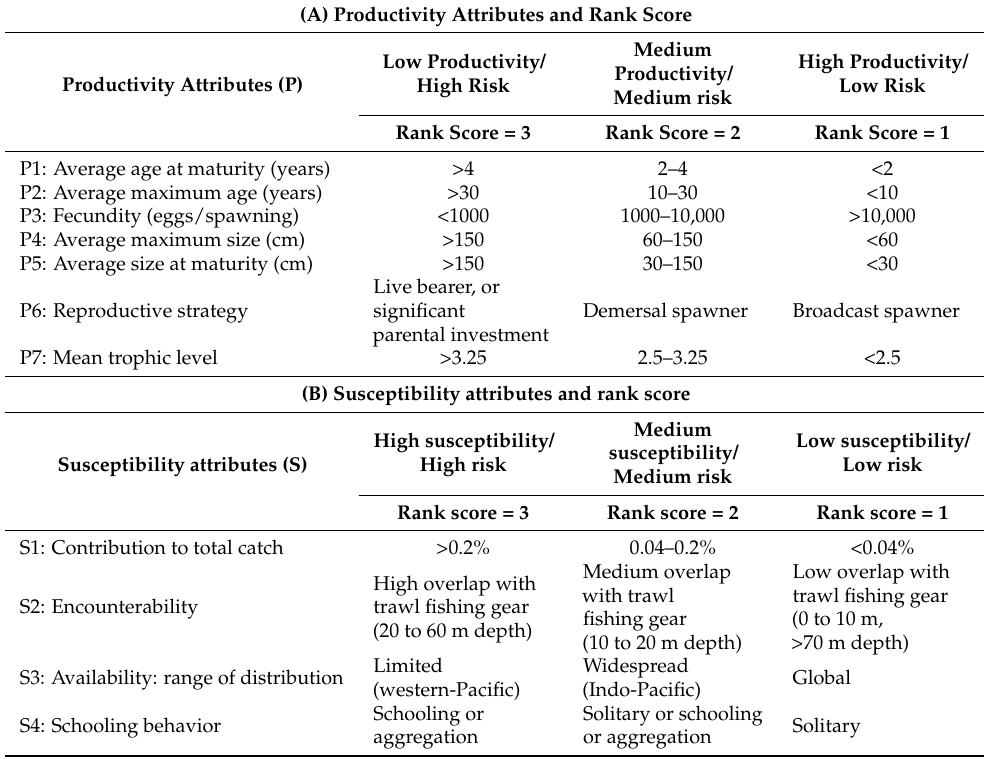
trawl fisheries in the Gulf of